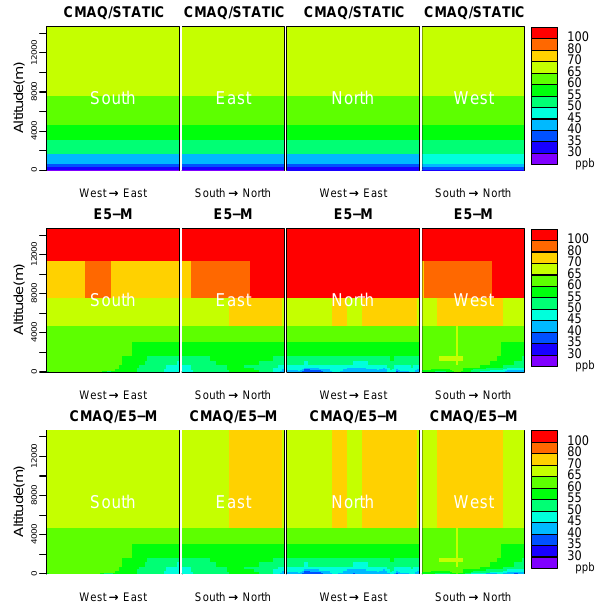
Fig. 2. Vertical cross-sections of time-averaged ozone concen- trations specified along the southern, eastern, northern, and west- ern boundaries of the CMAQ 36km modeling domain. row: ozone concentrations derived from the time-invariant clima- tological vertical profiles used in the CMAQ/STATIC simulations. Center row: ozone concentrations derived from the ECHAM5- MOZART simulations. Bottom row: ozone concentrations used in the CMAQ/ECHAM5-MOZART simulations after setting the con- centrations for layers 14 and 15 to the same value as for layer